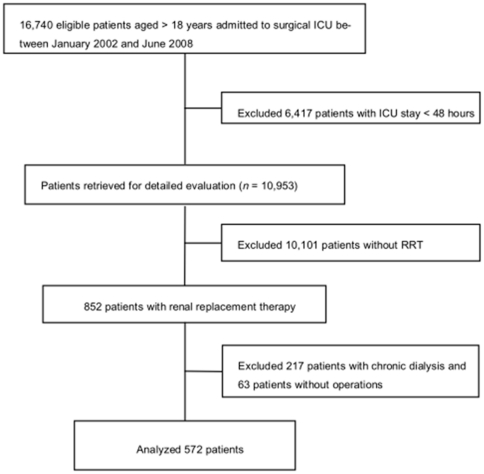
Flow diagram of the study population.